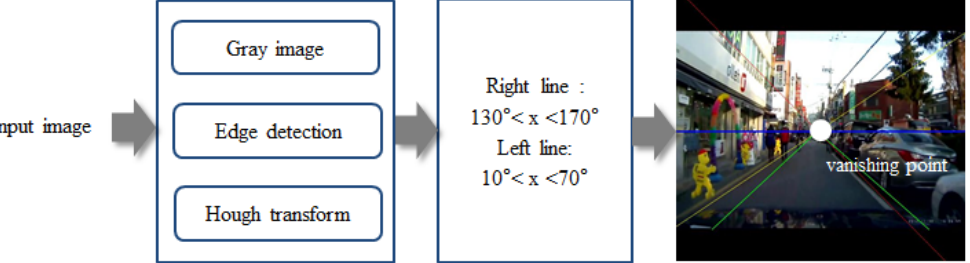
Figure 8. Steps for finding the two lines that will be used as guidelines for classification of the pedestrian’s location: The right panel shows an example of this process where more than two lines are detected from a line detection algorithm, the Hough transform. Among those lines, two lines are selected between specific angles.